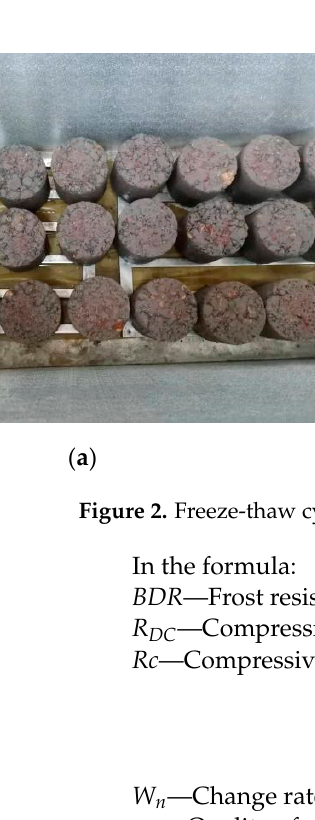
Table 5. Average and maximum shrinkage coefficients.